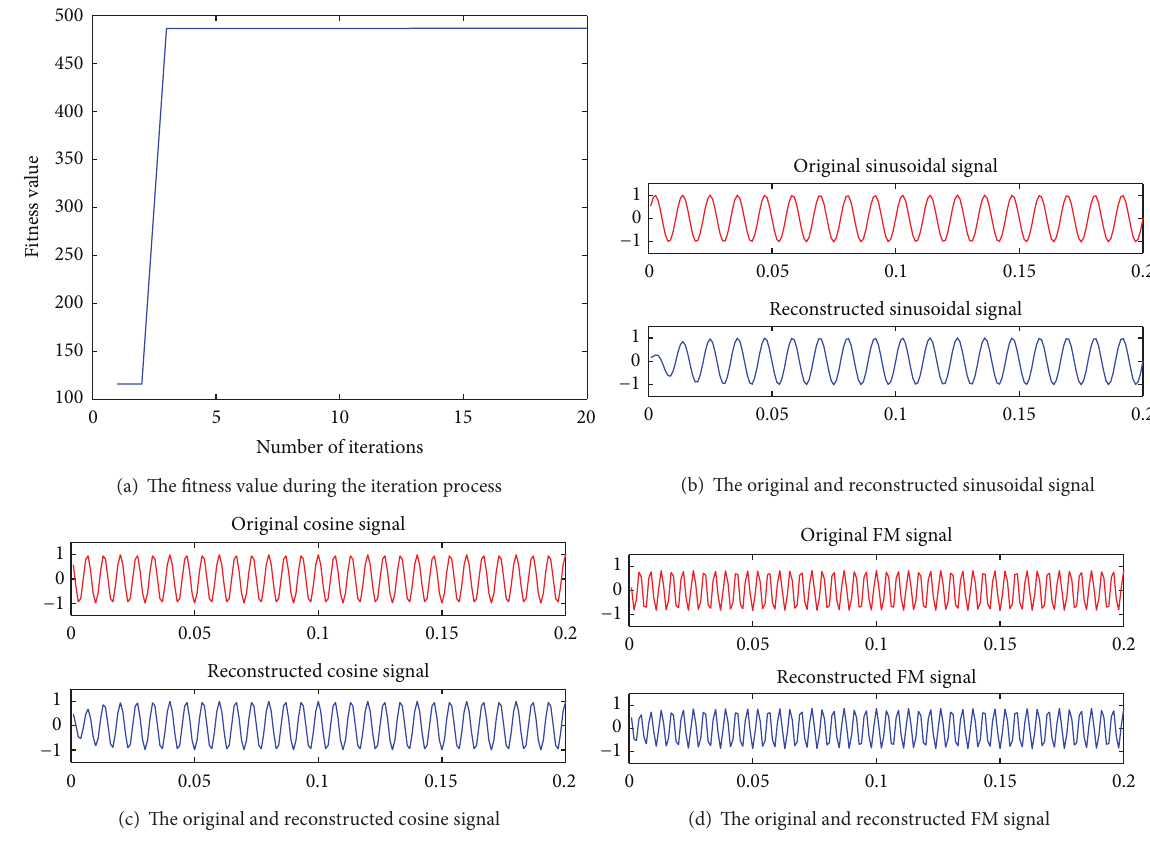
Figure 3: The result of VMD